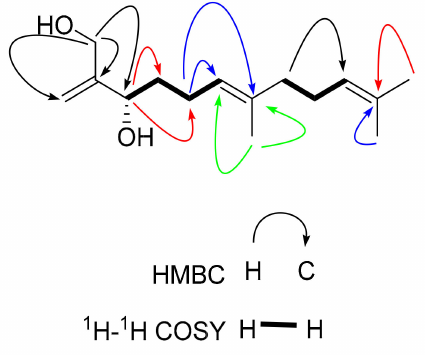
Figure 15. Key HMBC ( → ) and 1 H- 1 H COSY ( Figure 3. Key HMBC ( → ), 1 H- 1 H COSY( ) and ROESY ( ↔ ) correlations for Compound 1.